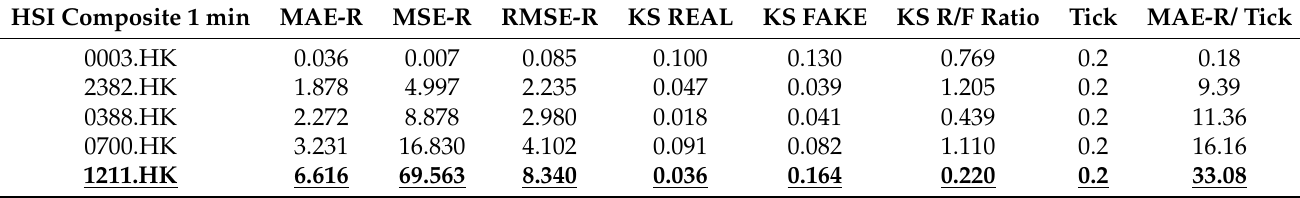
Figure 4. After mapping the price information by price, the generated prices (blue) are compared with one-minute market close prices (red). Table 3. We listed the performance of our model by MAE-R, MSE-R, RMSE-R, and KS tests.HSI Composite stocks are grouped by